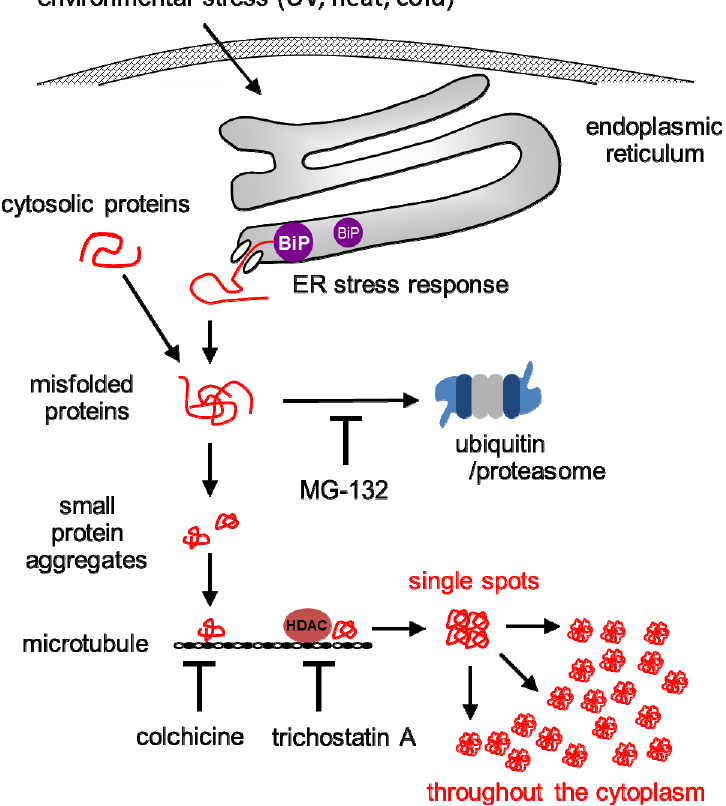
Figure 7. Theoretical model of misfolded protein aggregation in plant cells under environmental stress condition. Environmental stresses induce the ER stress response, including the upregulation of BiP in plant cells. Misfolded proteins are translocated from ER to the cytoplasm. Usually, misfolded proteins are degraded by proteasomes. Accordingly, misfolded protein aggregates are formed in plant cells following MG-132 treatment. Numerous misfolded proteins are likely generated in response to environmental stresses and the capacity of proteasomes to degrade them is exceeded. The aggregation of misfolded proteins occurs first in single spots and then throughout the cytoplasm. These aggregates might be formed in a microtubule-dependent manner, since colchicine and trichostatin A inhibits the aggregation. Histone deacetylase (HDAC) coordinates the formation of the aggregates on the microtubule through a yet unexplained manner(s). End lines indicate negative